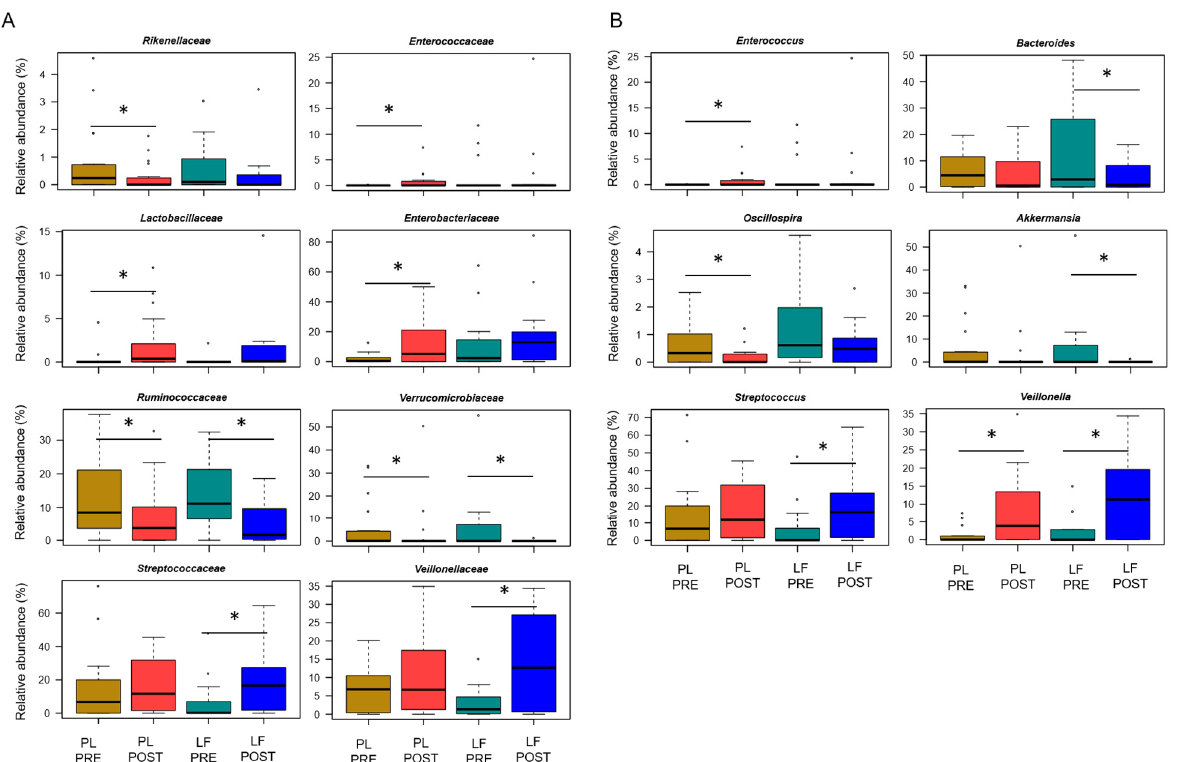
Figure 3. Gut microbiota changes in pediatric patients with hematological malignancies receiving lactoferrin or placebo supplementation during induction chemotherapy. Boxplots showing the relative abundance distribution of families ( A ) and genera ( B ) significantly differentially represented over time (PRE, before; POST, after), in relation to lactoferrin (LF) or placebo (PL) supplementation during induction chemotherapy (Wilcoxon test, * for p ≤ 0.05). Only taxa with relative abundance > 0.1% in at least 2 samples are shown.